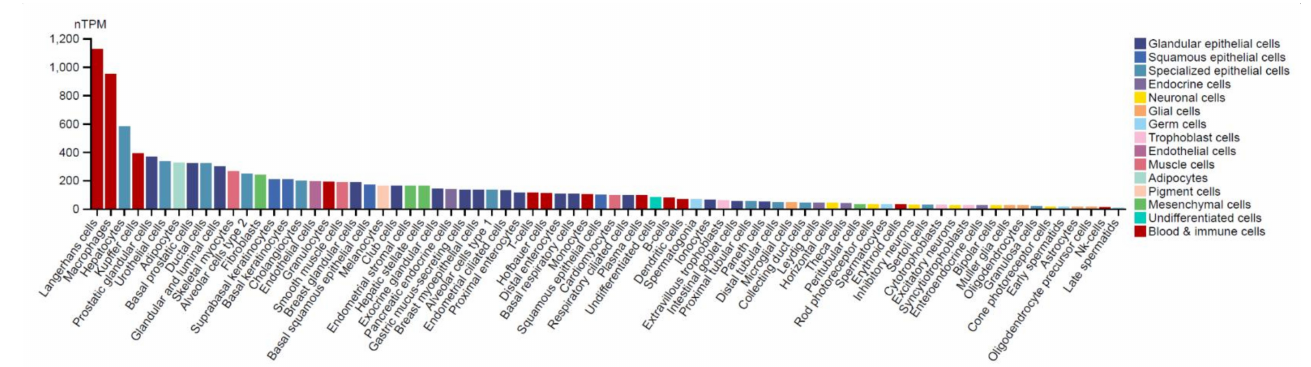
Figure 4. NAMPT RNA levels were measured by scRNA-seq in 192 specific cell type clusters, and the relative expression levels are presented. nTPM: TPM values of all samples were normalized separately using the trimmed mean of M values (TMM) to allow for between-sample comparisons and normalized transcript expression